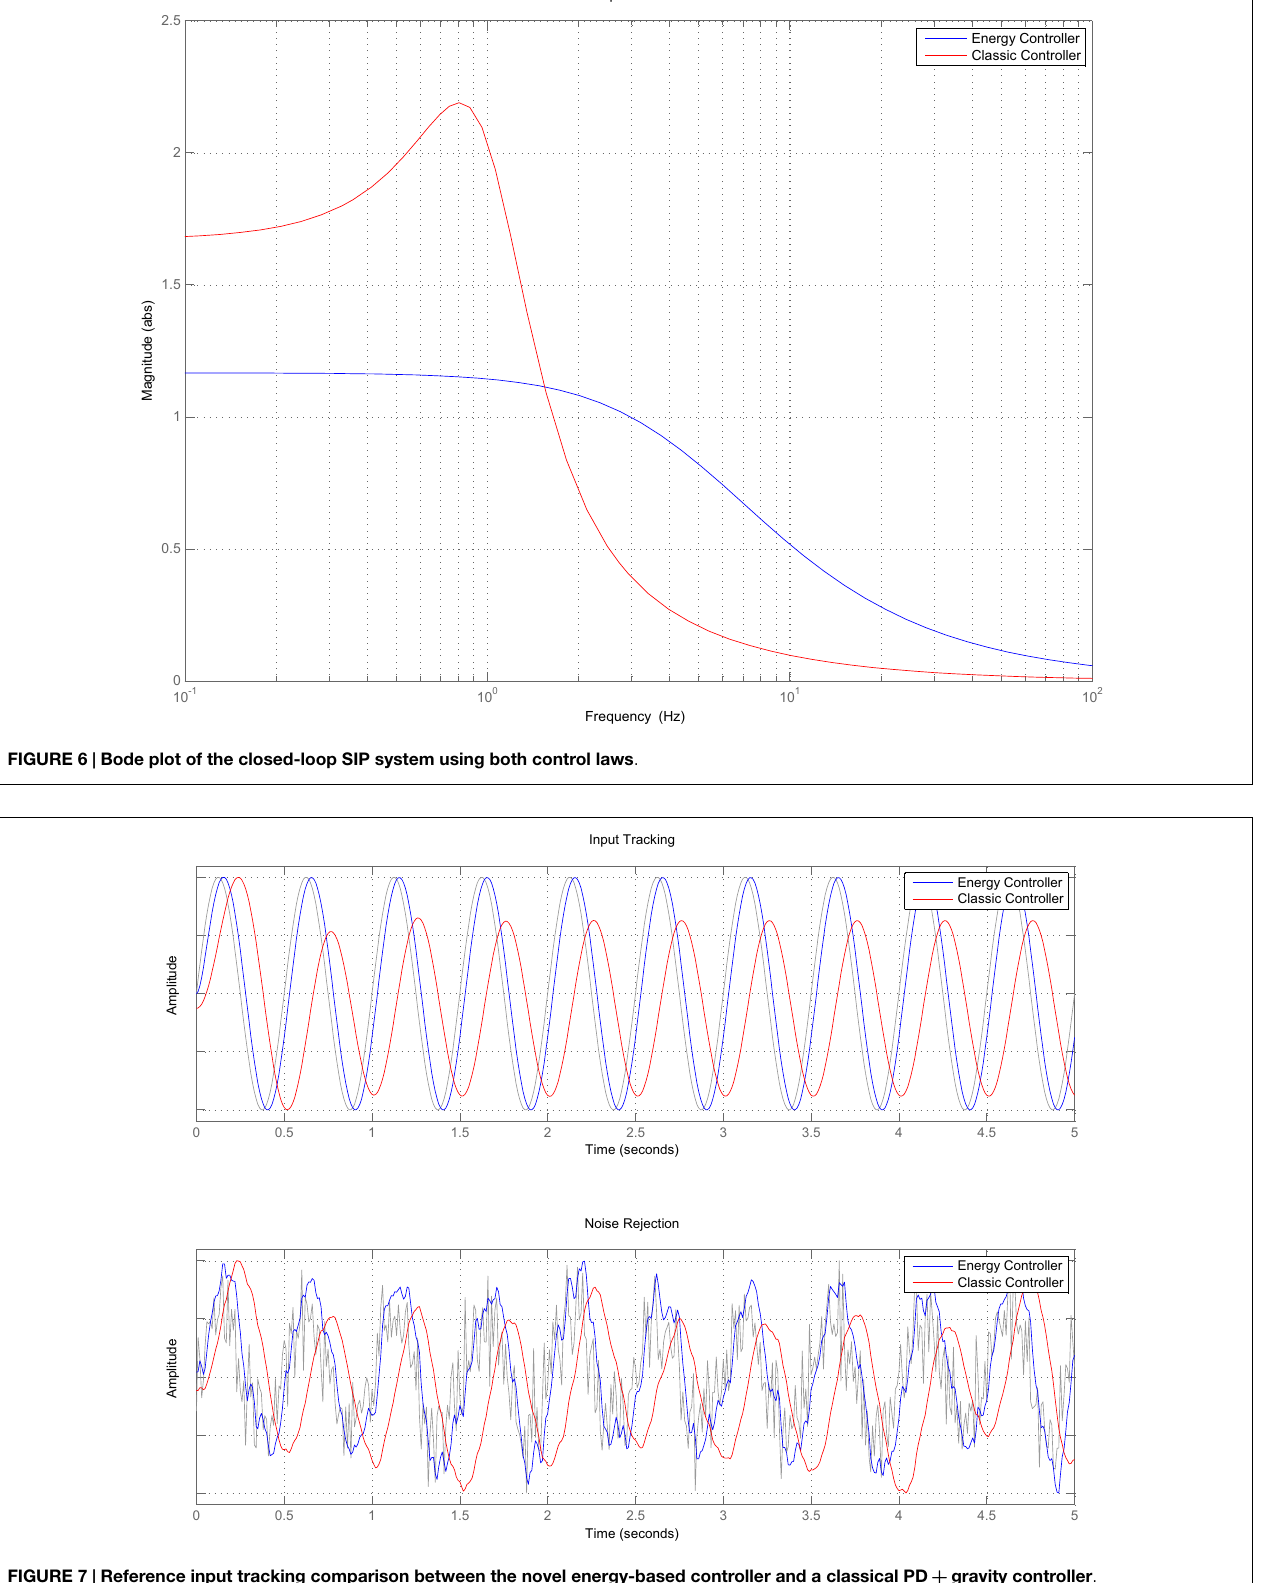
Frontiers in Robotics and AI |